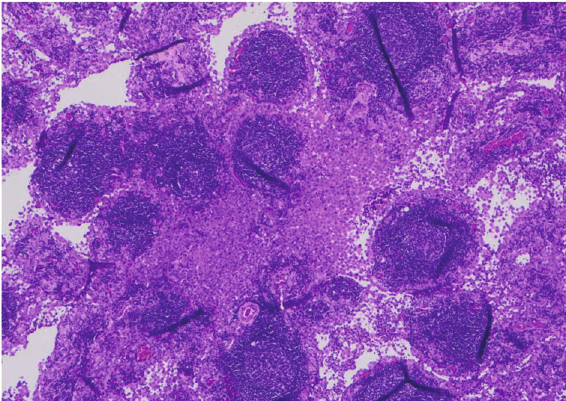
Figure 7: Sheets of neoplastic mesothelial cells with foci of chronic in fl ammation (pictured). Stains for calretinin, CK 5/6, and WT-1 were positive, con fi rming mesothelioma (not shown in this